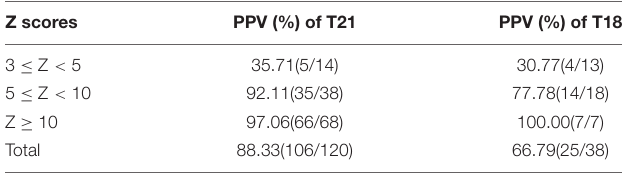
TABLE 5 | The PPV performance of T21 and T18 in different classification of Z scores.